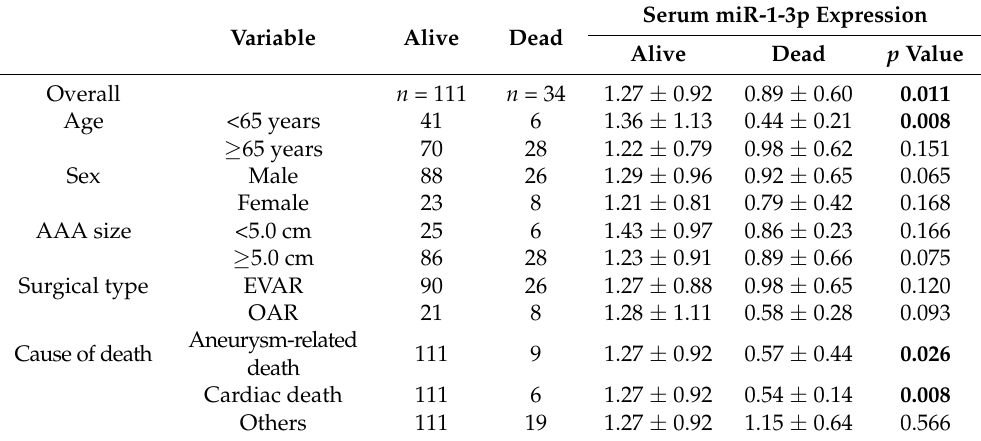
Table 3. Baseline serum miR-1-3p levels between alive and dead patients in the overall and stratified comparisons.